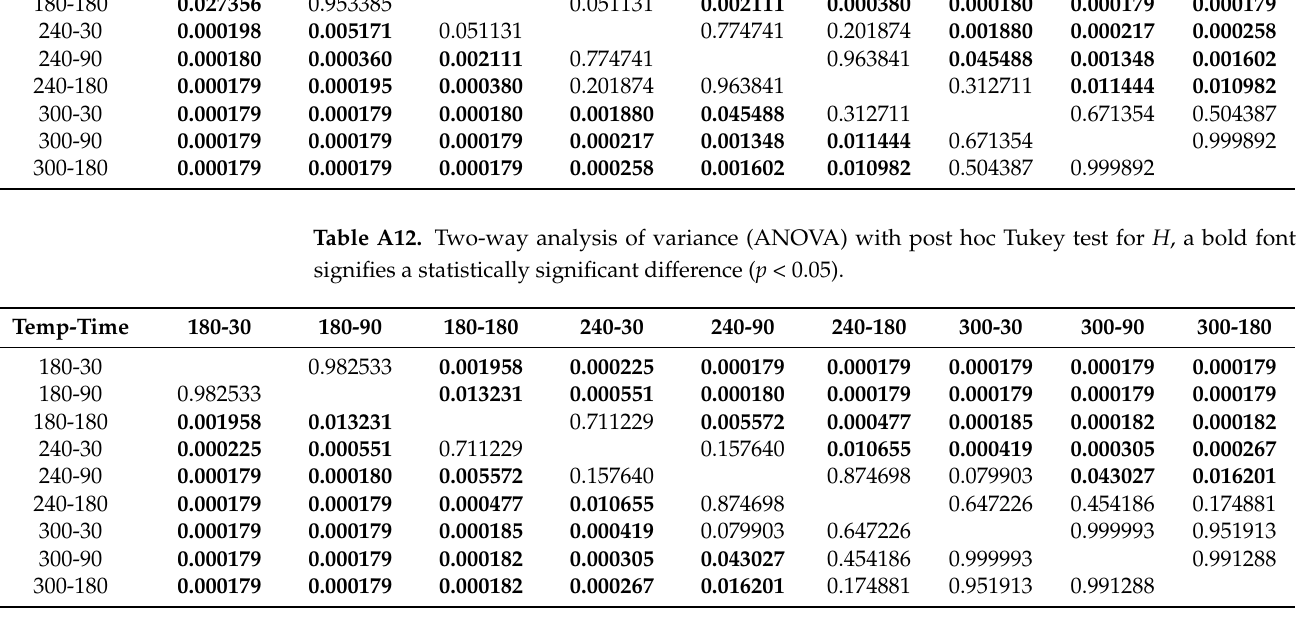
Table A13. Two-way analysis of variance (ANOVA) with post hoc Tukey test for N , a bold font signifies a statistically significant difference ( p < 0.05).